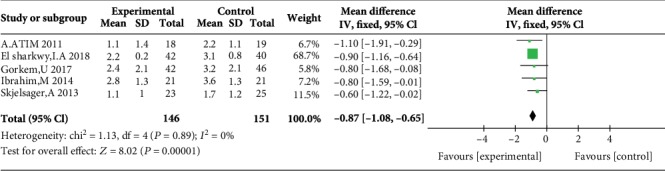
Postoperative pain scores at rest at 6 h.